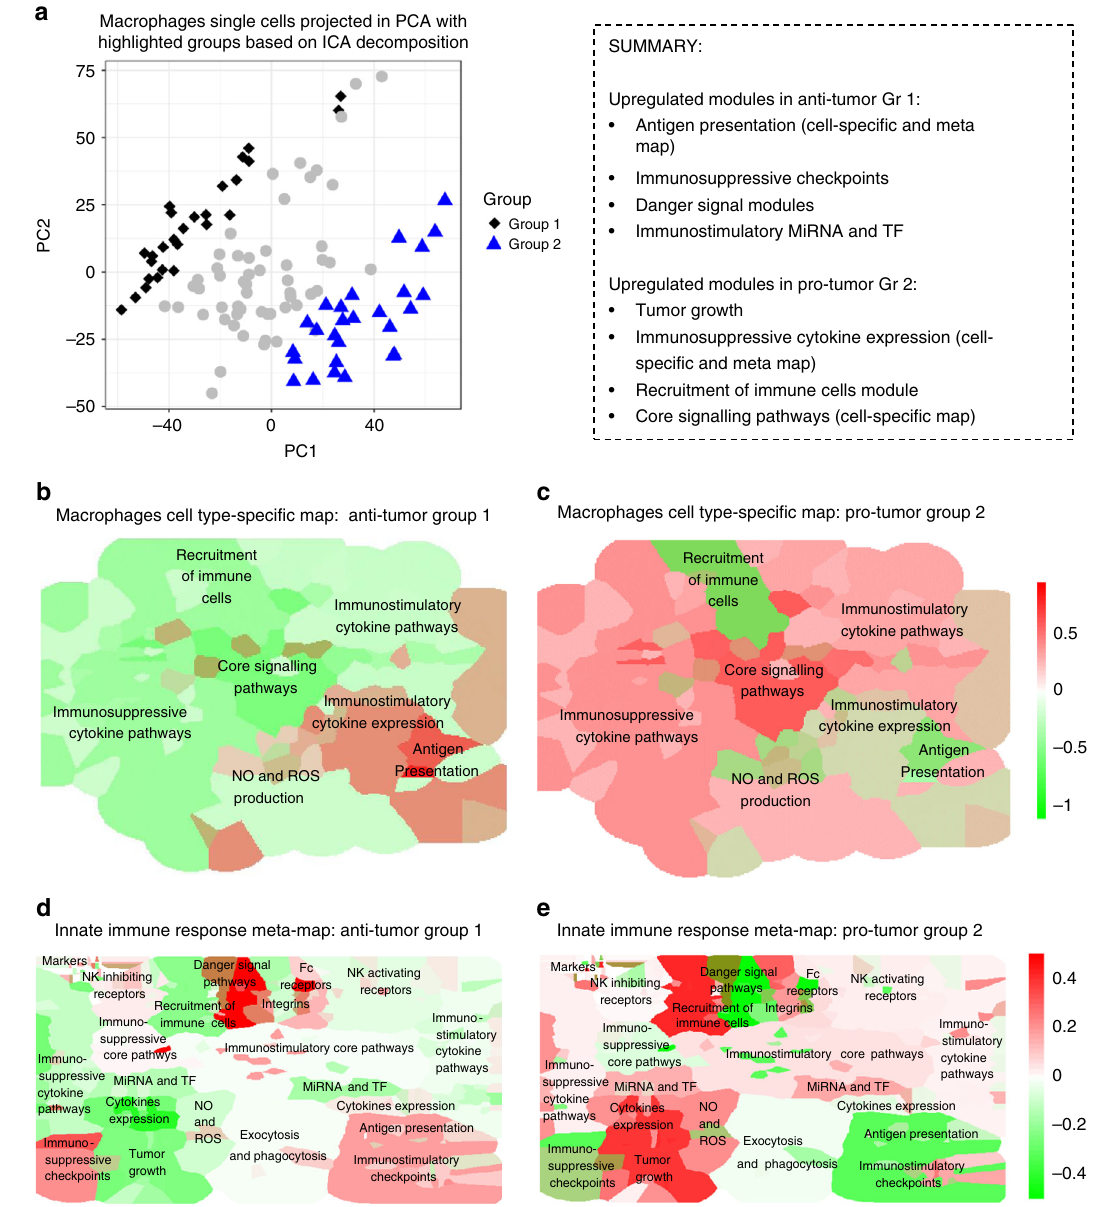
Fig. 4 Visualization of modules activity scores using expression data from melanoma macrophages. a Macrophages single cells in PC1 and PC2 coordinates space. Two groups, the fi rst and the fourth quartiles of distribution along the IC1 axis, are colored distinctly in blue and black. Staining of the macrophage cell-type-speci fi c map with modules activity scores calculated from single-cell RNAseq expression data for b Macrophages group 1 (Anti-tumor) and c Macrophages Group 2 (pro-tumor) cells. Staining of the innate immune meta-map with modules activity scores calculated from single-cell RNAseq expression data for d . Macrophages Group 1 (Anti-tumor) and e Macrophages Group 2 (Pro-tumor) cells. Color code: red — upregulated, green — downregulated module